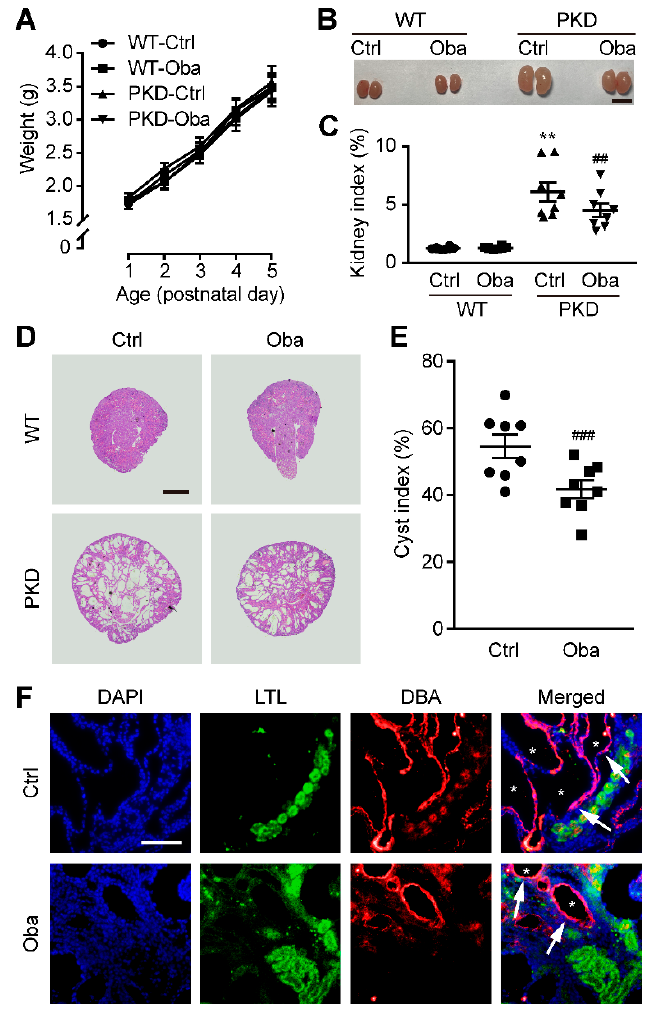
Figure 4. Inhibitory effect of obacunone on cyst development in PKD mice. ( A ) Weight curves of mice. ( B ) Representative images of the kidneys. Bar = 1 cm. ( C ) Kidney indices. ( D ) Hematoxylin- and eosin-stained pictures of kidneys. Bar = 400 μ m. ( E ) Cyst indices. ( F ) LTL (green), DBA (red) and DAPI (blue) fluorescence staining of PKD kidneys. Arrows indicate the collecting ducts, asterisks represent the cyst area. Bar = 50 μ m. Data are presented as means ± SEM. n = 8. ** p < 0.01 versus WT-Ctrl. ## p < 0.01, ### p < 0.001 versus PKD-Ctrl.